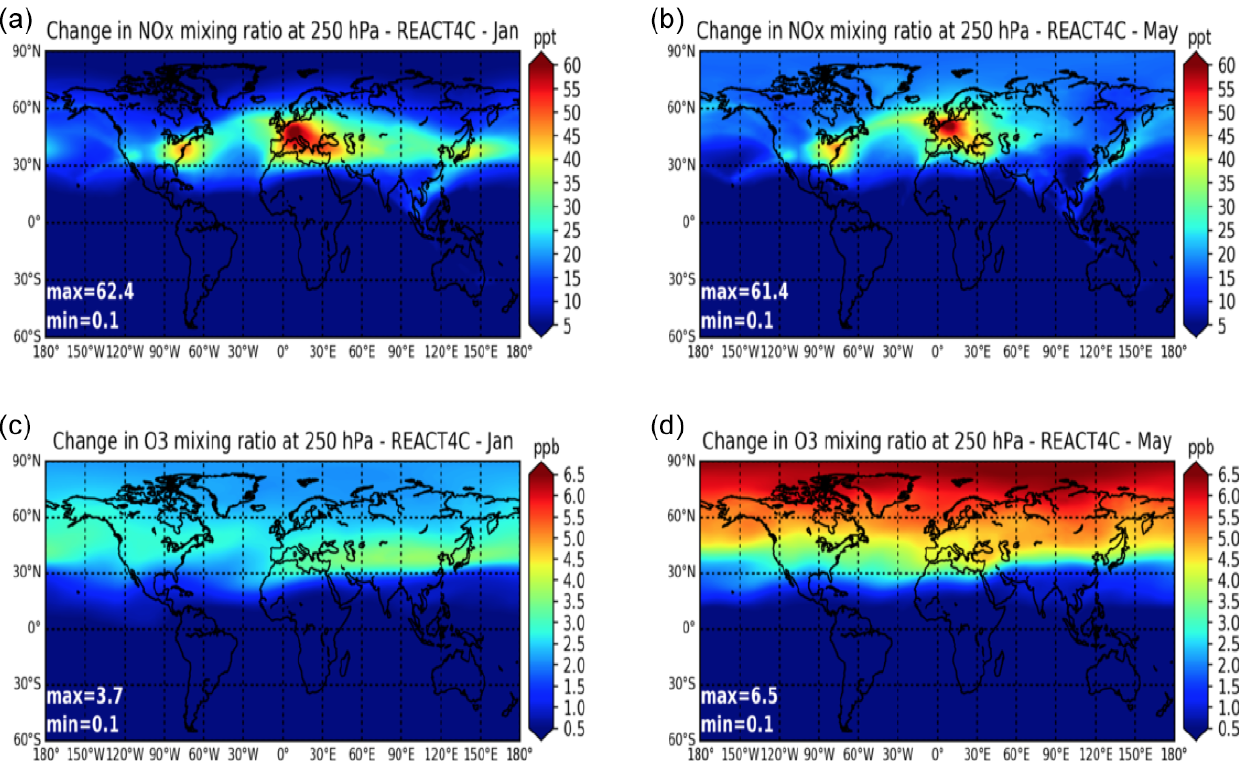
Figure 4. Spatial distribution of the 250hPa perturbations due to aircraft emissions for the month of January (a, c) and May (b, d) for the mixing ratios of NO x (pptv) and ozone (ppbv) for the REACT4C_2006